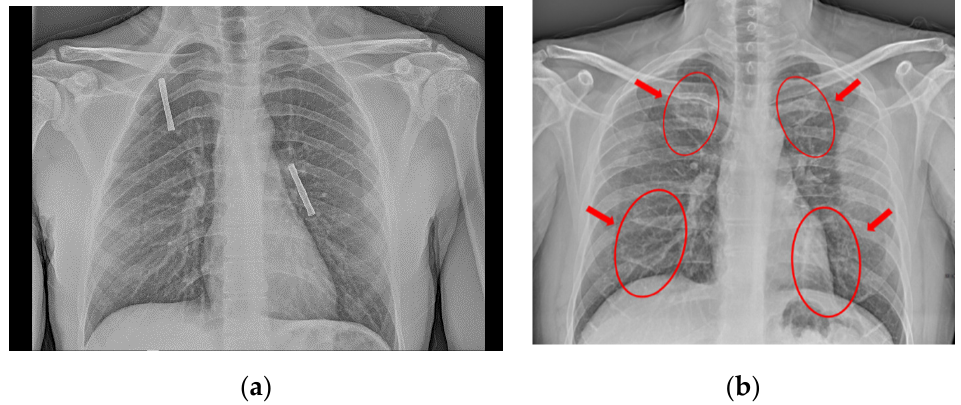
Figure 1. Examples of CXR images: ( a ) shows a healthy patient without any anomaly within the thorax; ( b ) shows a COVID-19-infected patient, bilateral opacities are found. Original images were obtained from (https://github.com/ieee8023/covid-chestxray-dataset), a public COVID-19 dataset. Annotations were manually performed by us with a doctor assistant.